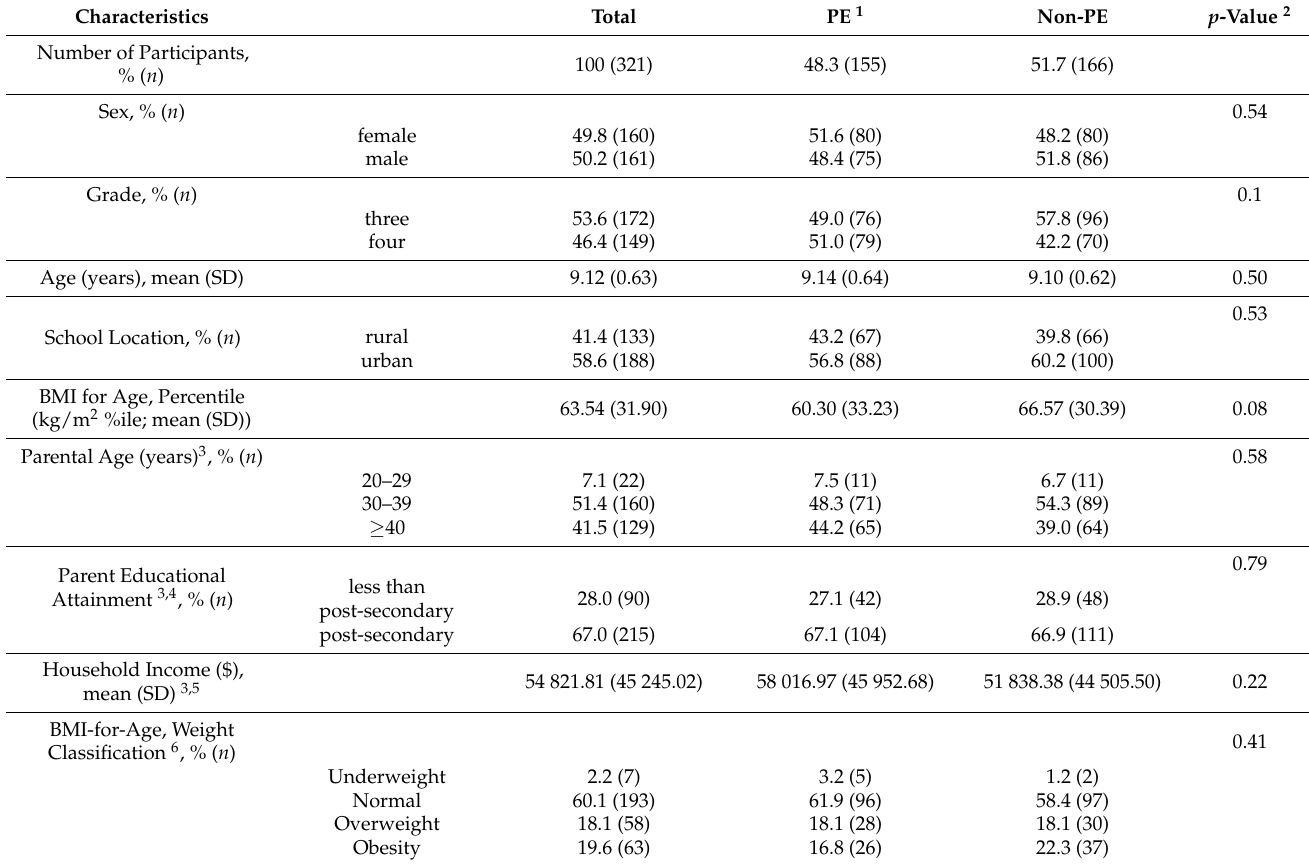
Table 1. Demographic characteristics by picky eating